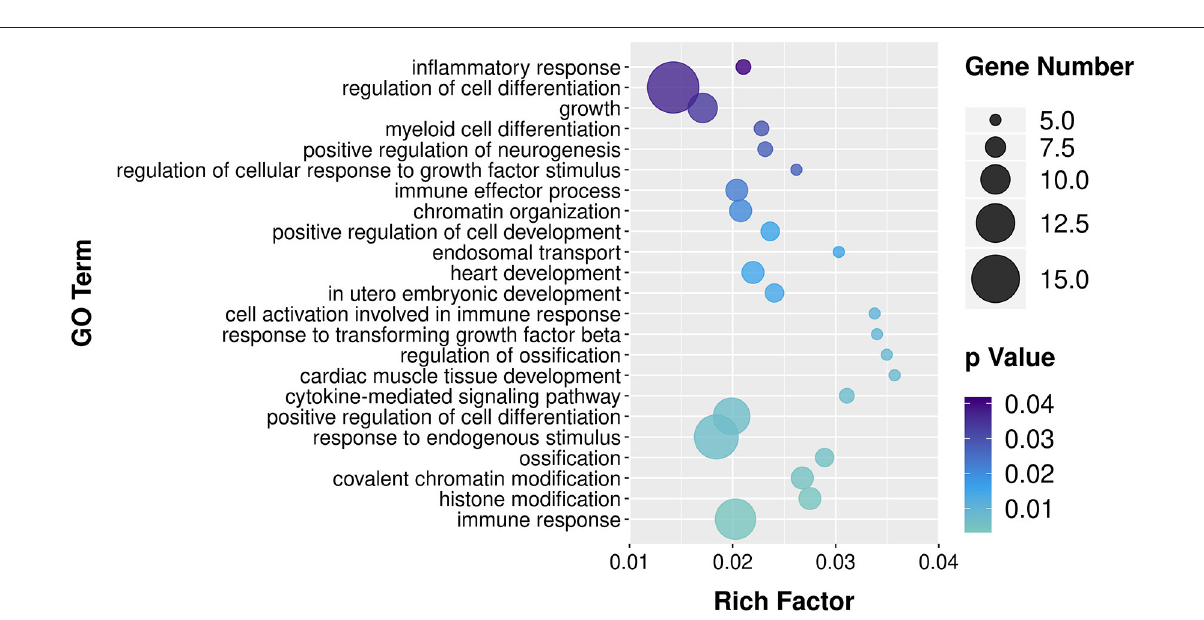
FIGURE 3 | Enriched biological process Gene Ontology (GO) terms among the source genes of differentially expressed circRNA molecules. The x-axis indicates the enrichment factor of the GO terms, while the names of the GO terms are shown on the y-axis. The size and color of the dot indicate the number of source genes and the p -value (Fisher’s exact test), respectively. The enrichment factor indicates the number of differentially expressed genes/total genes for each GO